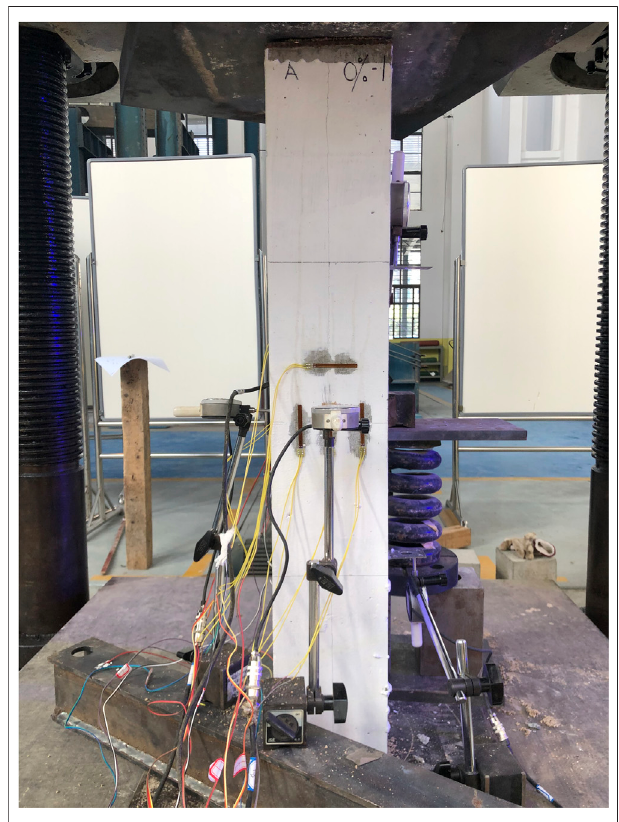
FIGURE 4 | Loading set-up of the axial compression